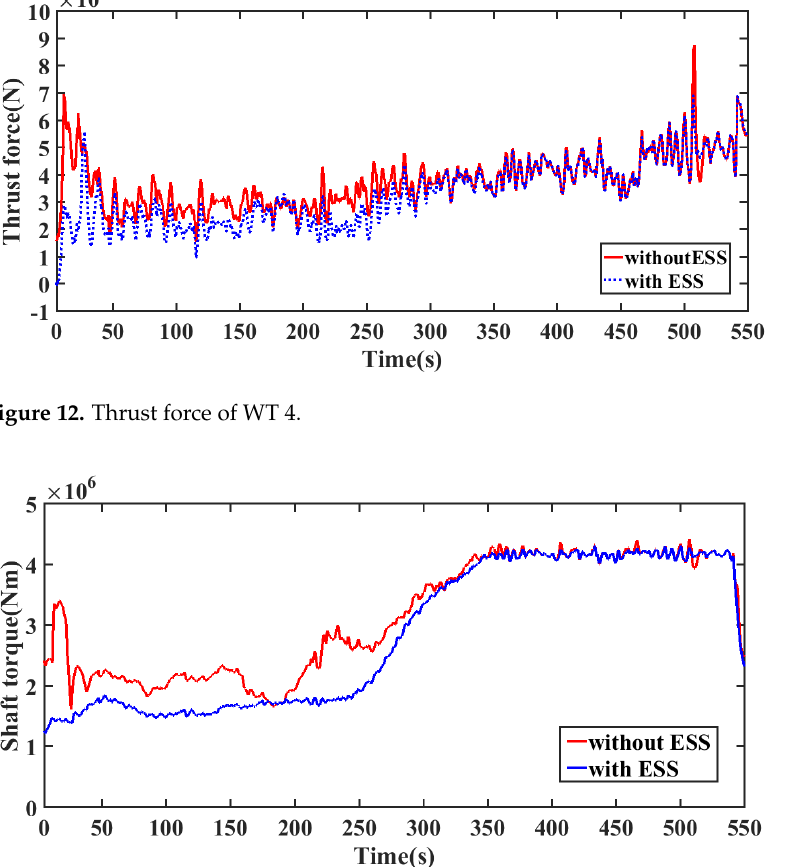
Figure 15. Active power output of WT4.